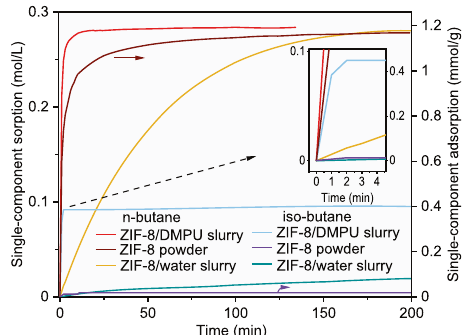
Fig. 1 | Comparison of the sorption kinetics of single-component in different media. Kineticpro fi lesofn-butaneandisobutaneonZIF-8powder(rightaxis),ZIF- 8(35wt%)/DMPUslurry,andZIF-8(25wt%)/waterslurry(leftaxis)at293.15Kandan initial gas-slurry volume ratio of about 6.8 (initial gas – solid volume ratio of about 26.7 for ZIF-8 powder). The pro fi les were obtained via P-time curves shown in Supplementary Fig.